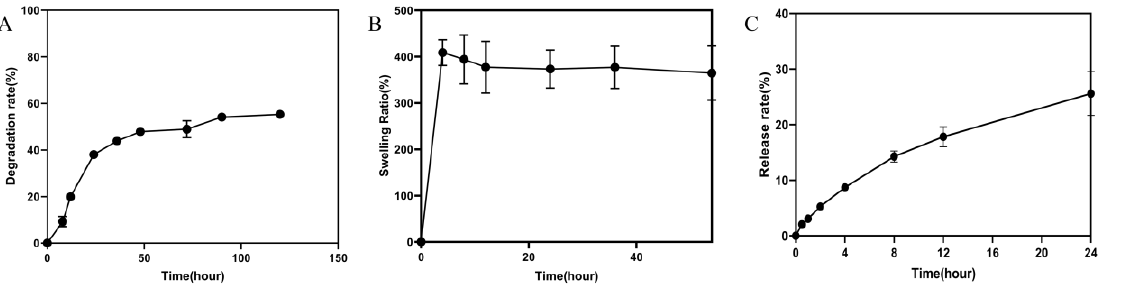
Figure 6. Degradation rate and swelling ratio of the hydrogel. ( A ) The degradation rate and ( B ) swelling ratio of the hydrogel. ( C ) The release rate of the scolopin2-loaded hydrogel.